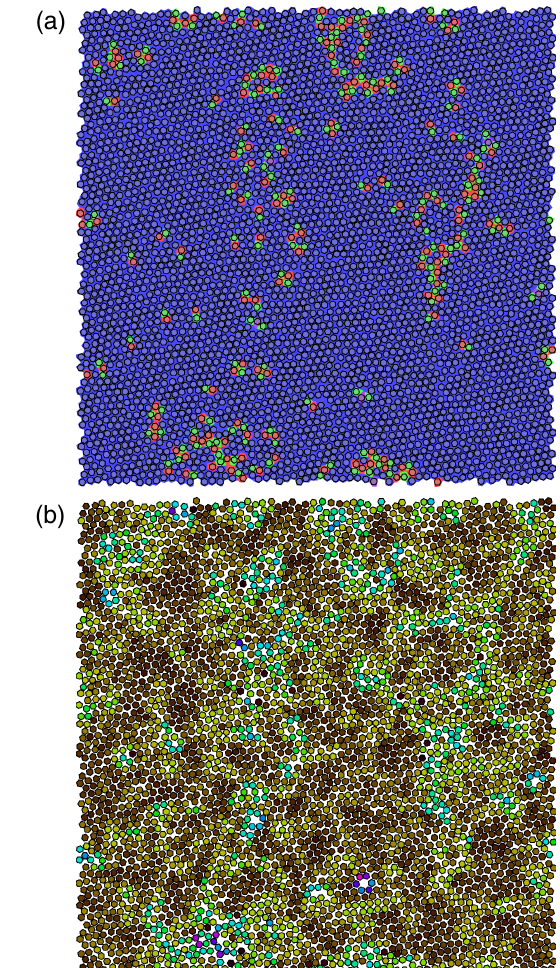
FIG. 5. Representative snapshot of the hexagon system N ¼ 128 2 at density ϕ ¼ 0 . 690 . (a) Particles are colored by the number of edges in the Voronoi cell. Red, blue, and green cells have seven, six, and five sides, respectively. (b) Particles are colored by h IQ i − IQ. Blue indicates large deviation from h IQ i and yellow indicates little